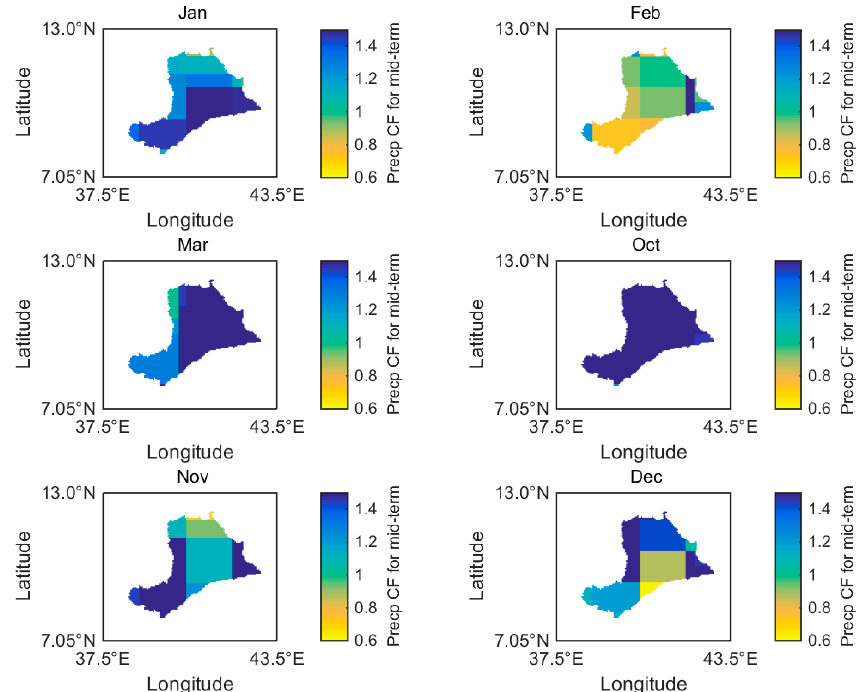
Figure 9. Precipitation change factors for January to March and October to December months for mid-term period, 2031–2055 (based on the median of the three models).